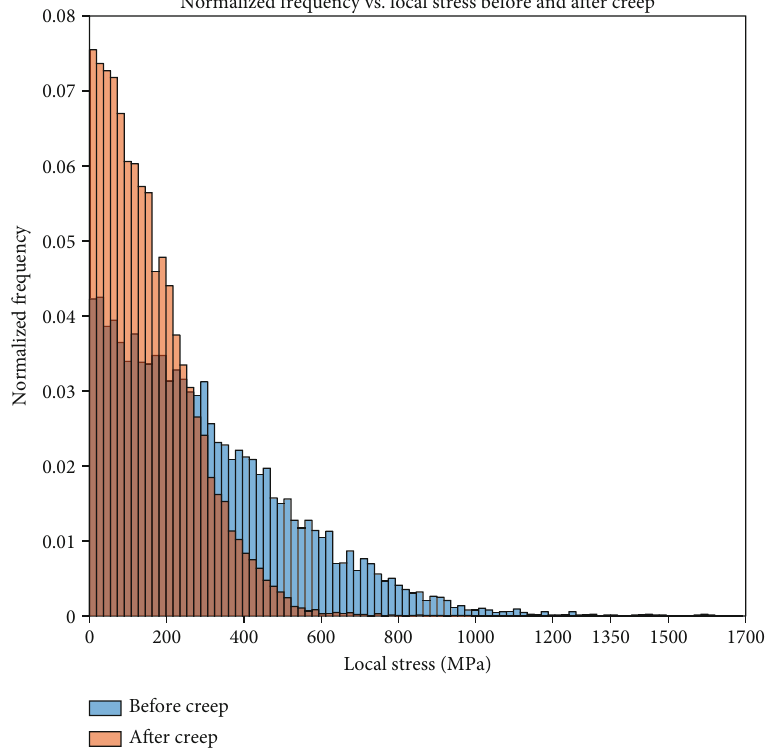
Figure 22: Histogram of local contact stress before and after the creep stage. The SLS model is used as the input, H = 1 : 0 , RMS = 50 μ m , λ = 1000 μ m , σ = 10MPa , and the time duration is 5 τ c